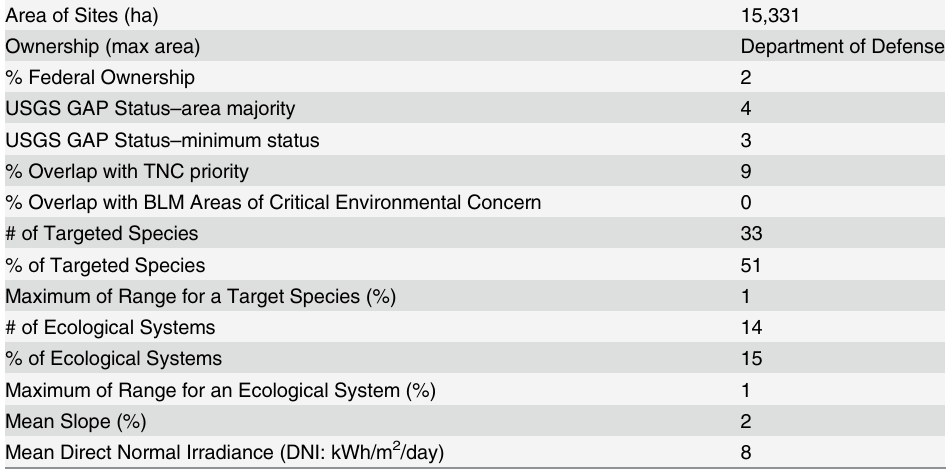
Table 1. Impact site characteristics from the hypothetical proposed projects.